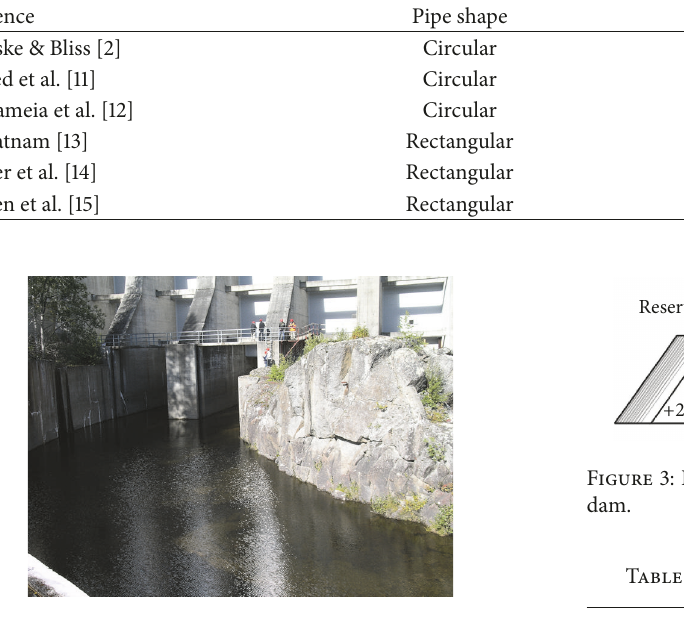
Figure 2: The bottom outlet seen from downstream, at a low tailwater stage.